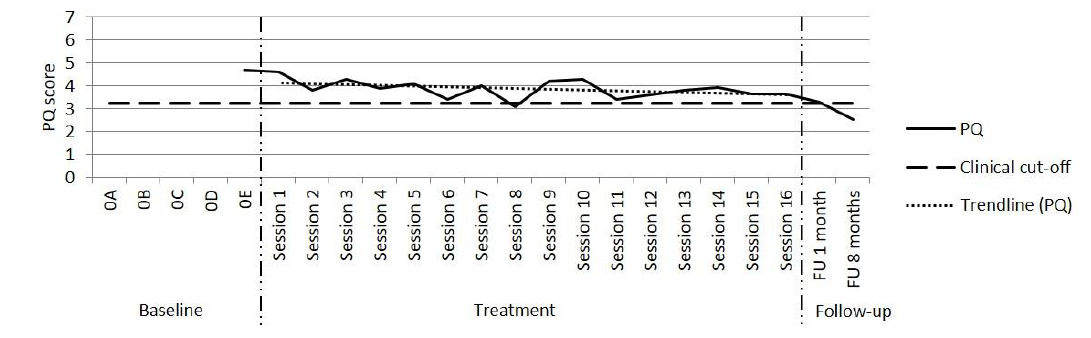
Figure 4: Giovanni’s weekly personal problems (PQ)